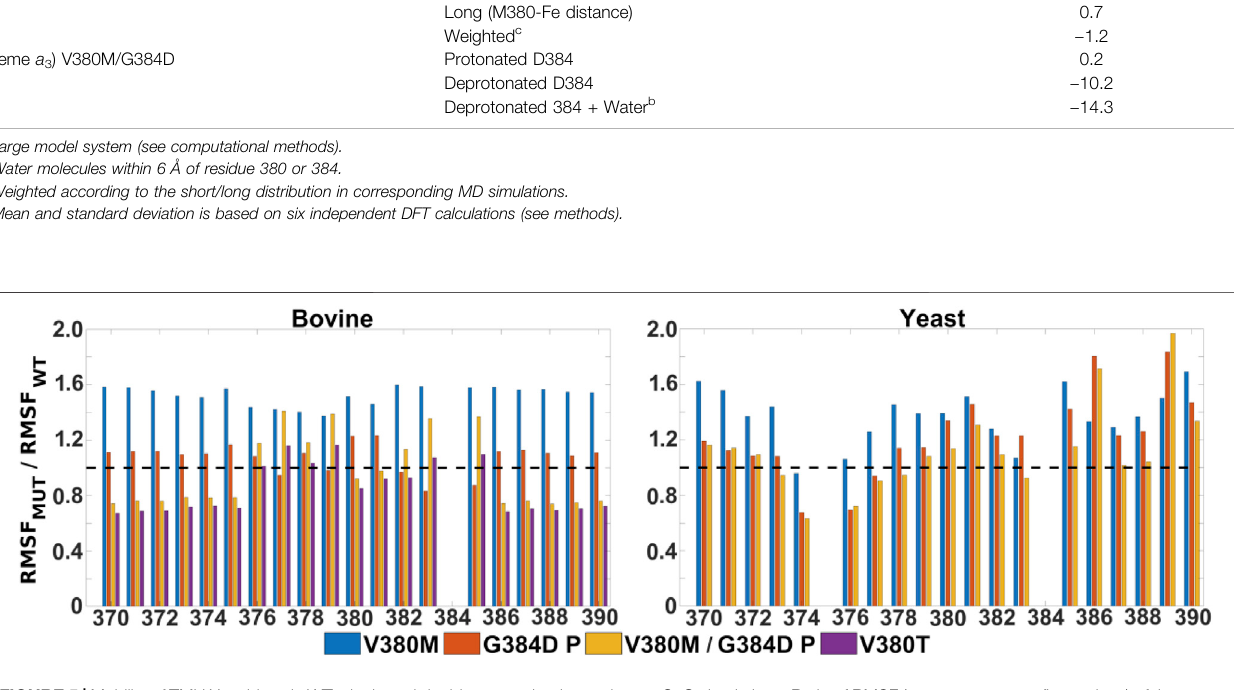
FIGURE 5 | Mobility of TMH X residues in WT, single and double mutant bovine and yeast C c O simulations. Ratio of RMSF (root mean square fl uctuations) of the sidechains of helix X from mutant and WT simulations. Bovine (left) and yeast (right) C c O simulations in their fully oxidized states are displayed with data from V380M (blue), protonated G384D (P, red), protonated V380M/G384D (P, yellow) and V380T (purple). The dashed black line (y (cid:2) 1) indicates a WT-like